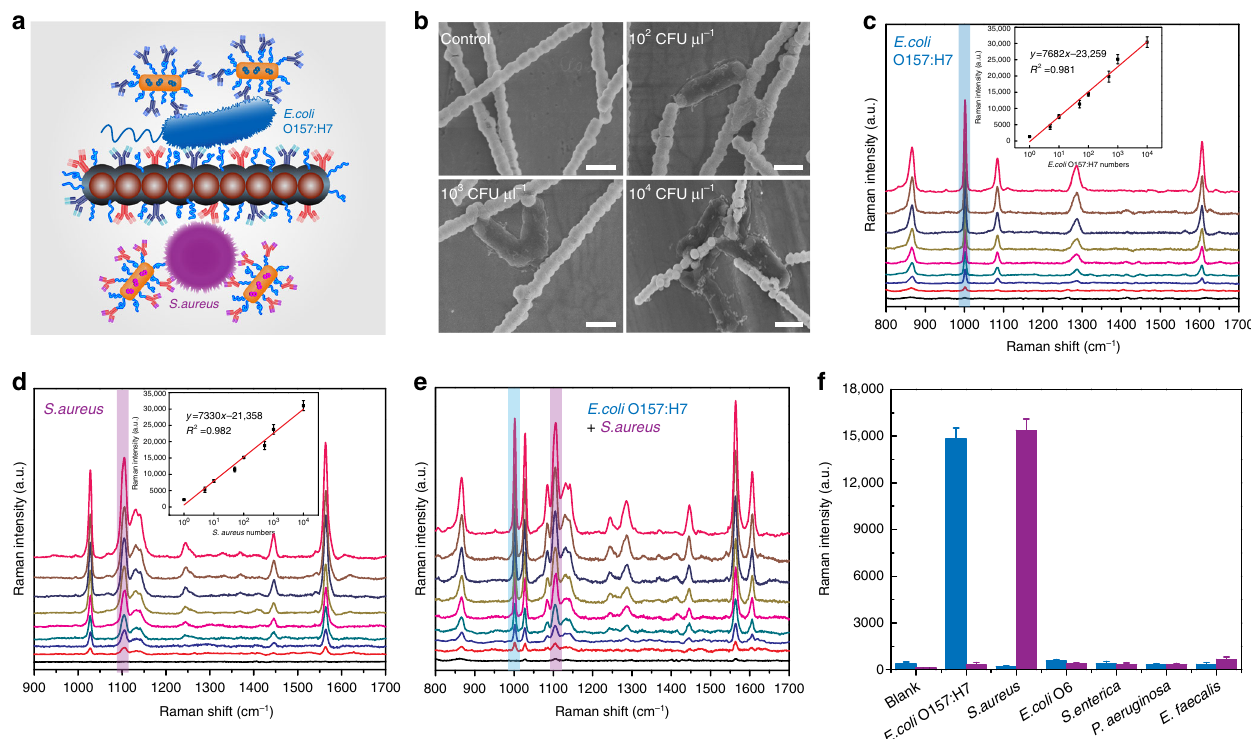
Fig. 5 Multiplexed detection of bacteria by the MiChip assay. a Schematic illustration of the simultaneous detection of E. coli O157:H7 (blue) and S. aureus (purple). b SEM images of Magchains- E. coli O157:H7-SERS probes complex with varying concentrations of E. coli O157:H7. Scale bar: 1 μ m. c , d SERS spectra of E. coli O157:H7 and S. aureus at different concentrations (ranging from 0 to 10 4 CFU μ l − 1 ). Insets are calibration curves generated by plotting the SERS peak intensities at 1001.6 and 1104.9 cm − 1 as a function of the logarithm of E. coli O157:H7 and S. aureus , respectively. e SERS responses to a mixture of the two pathogens ( E. coli O157:H7: S. aureus = 1:1, ranging from 0 to 10 4 CFU μ l − 1 ). f The MiChip assay results of saliva samples spiked with E. coli O157: H7, S. aureus and other control bacteria. The error bars in c – f represent the s.d. of triplicates ( n =